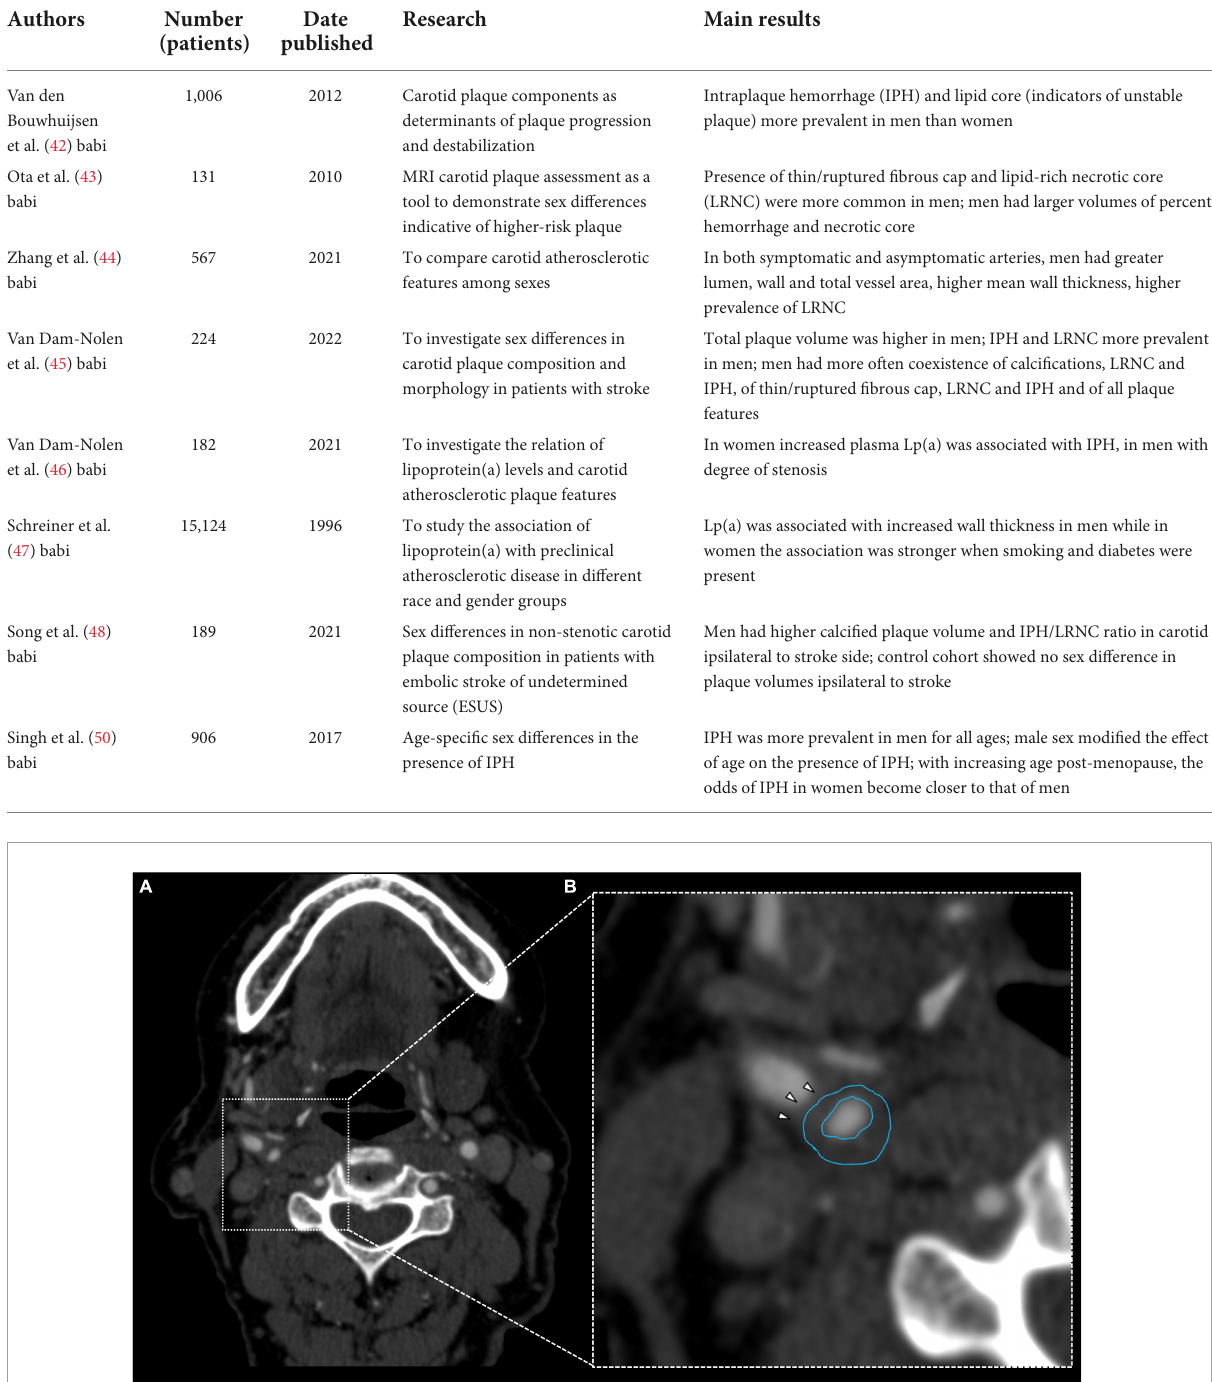
imaging biomarkers of vulnerability exist and that they predict stroke risk: intraplaque hemorrhage (IPH), best seen with MRI (39) but recently studied with CT as well (40); lipid-rich